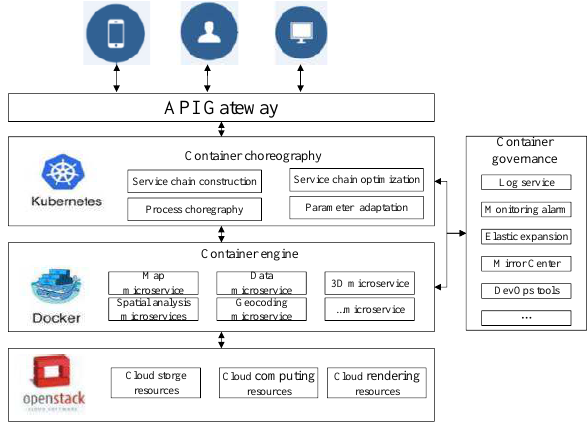
Figure. 4 Container management of microservices